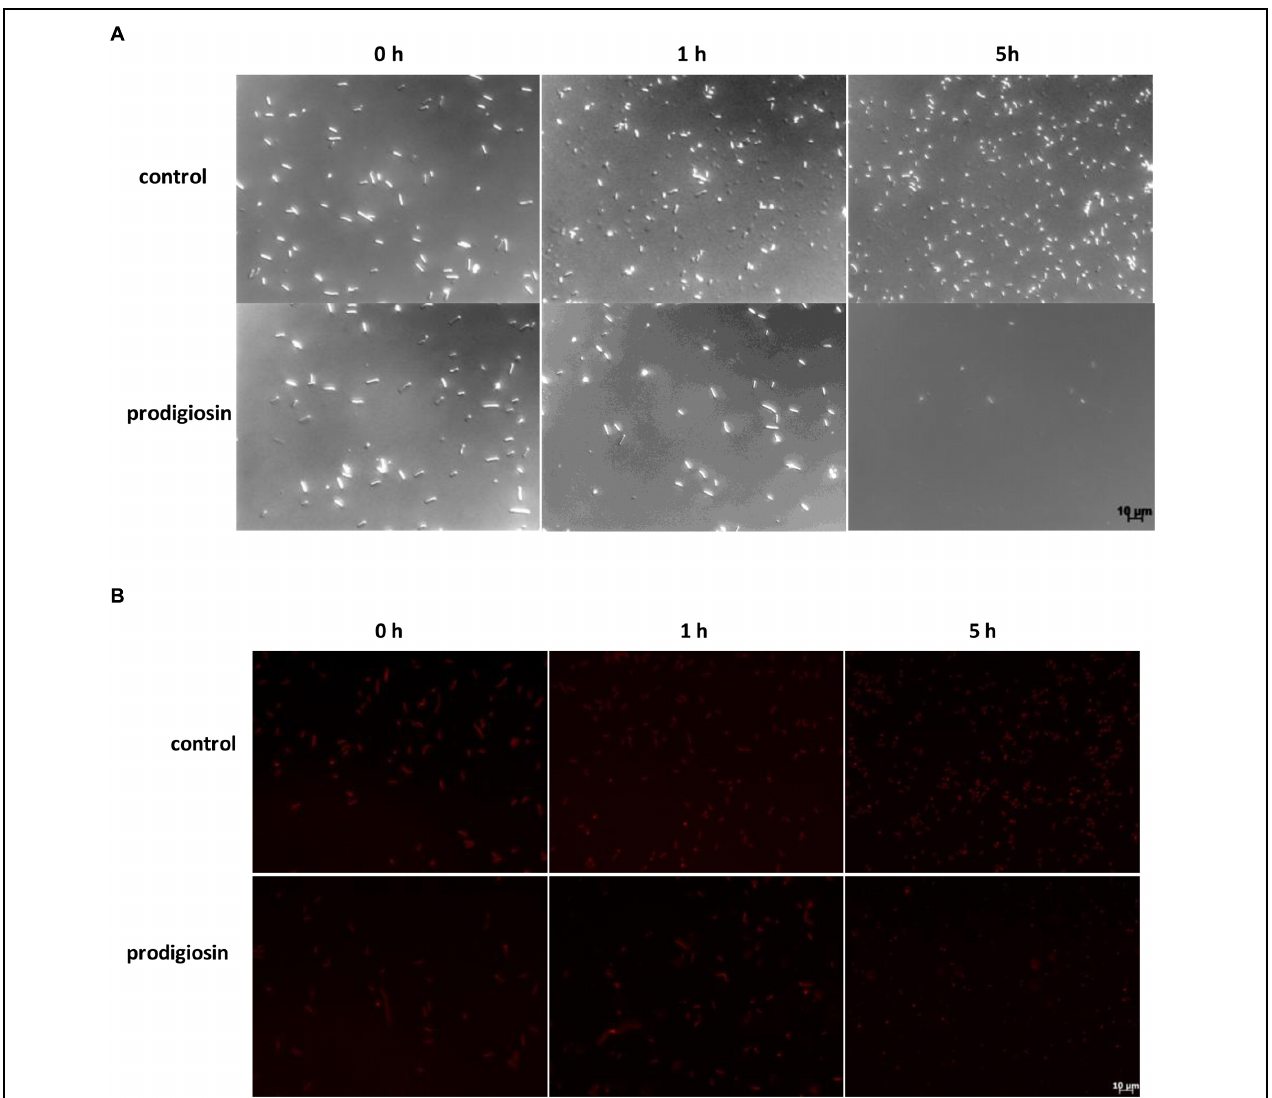
FIGURE 2 | Bacillus subtilis PS-216 wt cells (A) and B. subtilis PS-216 amyE ::P hyperspank - mKate2 (B) grown in LB medium at 37 ◦ C and 200 rpm observed by DIC and fluorescent microscopy at 0, 1, and 5 h after the addition of either 5.9 mg L − 1 of prodigiosin or 0.19% (V/V) of ethanol in control samples in the middle of the exponential phase. The scale bar represents 10 μ